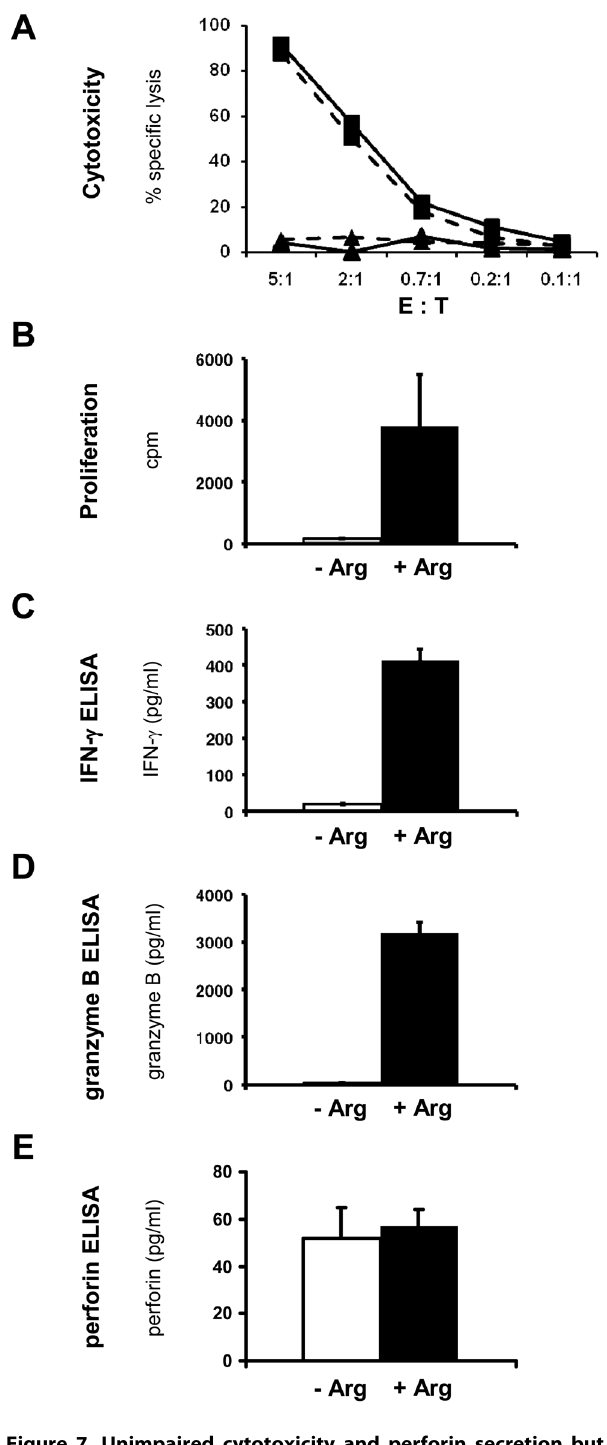
Figure 7. Unimpaired cytotoxicity and perforin secretion but severely suppressed proliferation and effector molecule secre- tion of retrovirally transduced CMV specific human CD8 + T cells. Human primary CD8 + T cells retrovirally transduced with a TCR specific for the CMV peptide pp65 aa495–503 ( & ) or mock transduced T cells ( m ) were activated with K562-A2 cells pulsed with the cognate pp65 aa495–503 peptide (100 nM) in the presence (–––) or absence (- - -) of arginine at the indicated E:T ratios (incubation time 4 h). T cell mediated, antigen specific tumor cell cytotoxicity was assessed by [ 51 Cr]-Chromium release assay ( A ). In parallel, identical T cell-K562-A2 co-cultivation assays were set up at an E:T ratio of 20:1 for 48 h ( B–E ).